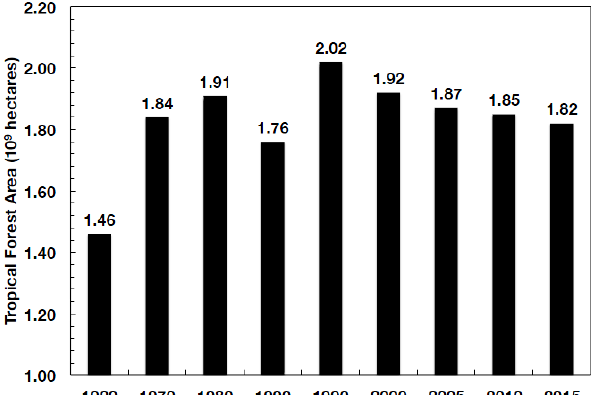
Figure 4. Area of tropical forests between the 1920s [89] and 2015 [3,82,90,91]. The 1990 estimates are both from the Food and Agriculture Organization (FAO), but estimated at different times; the last five estimates are from 2015. We selected these estimates as the most credible for their time because they contained supporting empiric information. Nevertheless, each estimate has unique assumptions and definitions that preclude precise comparisons among them.